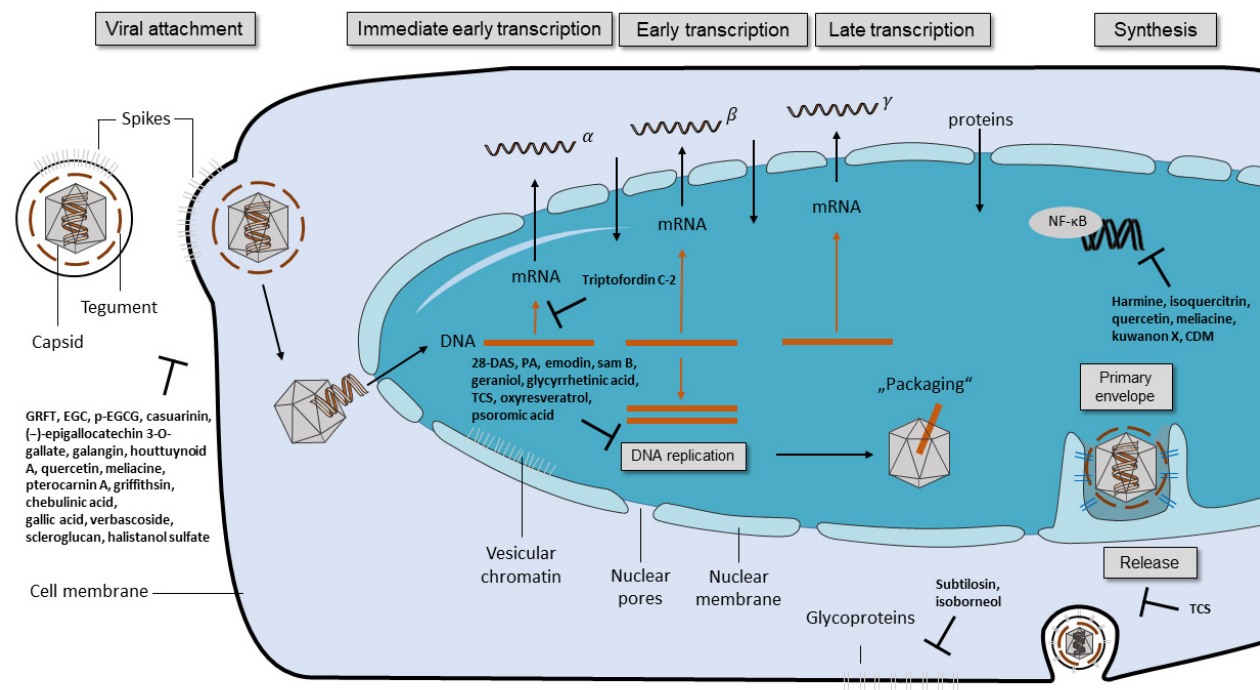
Figure 3. Replication cycle of herpes simplex viruses, including the targets of different natural antiviral compounds. During viral attachment, the viral glycoproteins B, D, and heterodimers of gH/gL bind to the host cell receptors. The transcription phase is divided into immediate-early, early, and late transcription where HSV genes are transcribed as α -, ß-, and γ -genes, respectively. These mRNAs are translated into immediate-early, early, and late proteins. Following DNA replication and the synthesis of the viral capsid, the primary envelopment of the capsid takes place. Subsequently, the capsids are released from the nucleus. Then, virions are released after secondary envelopment. Antiviral compounds may directly interfere with the distinct steps of the viral replication cycle or influence the cellular factors that are important for viral replication. Substances disturbing the viral replication cycle are 28-DAS, PA, emodin, sam B, geraniol, glycyrrhetinic acid, TCS, oxyresveratrol, and psoromic acid. Compounds such as harmine, isoquercitrin, quercetin, meliacine, kuwanon X, and CDM exhibit antiviral effects by addressing the primary essential cellular processes. The transcription factor NF- κ B is activated by HSV-1 and HSV-2, which favors the infection. GRFT = griffithsin, EGC = epigallocatechin, p -EGCG = palmitoyl-EGCG, 28-DAS = 28-deacetylsendanin, PA = psoromic acid, TCS = trichosanthin, CDM = 1-cinnamoyl-3,11-dihydroxymeliacarpin.